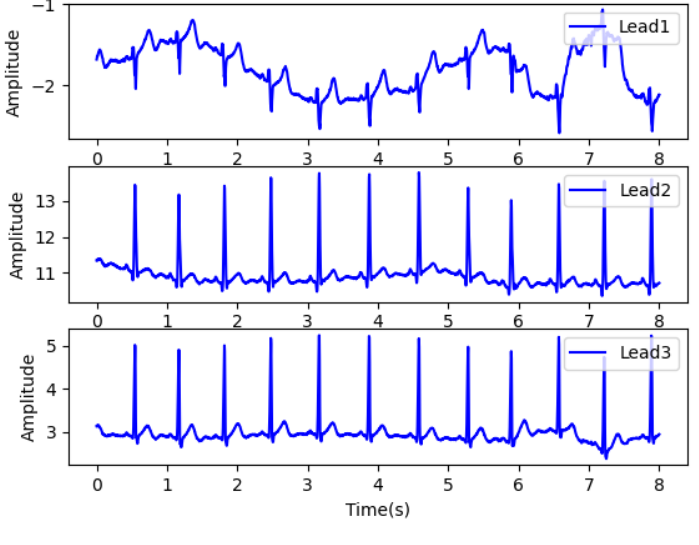
Figure 2. Three-lead ECG signal collected by smart ECG